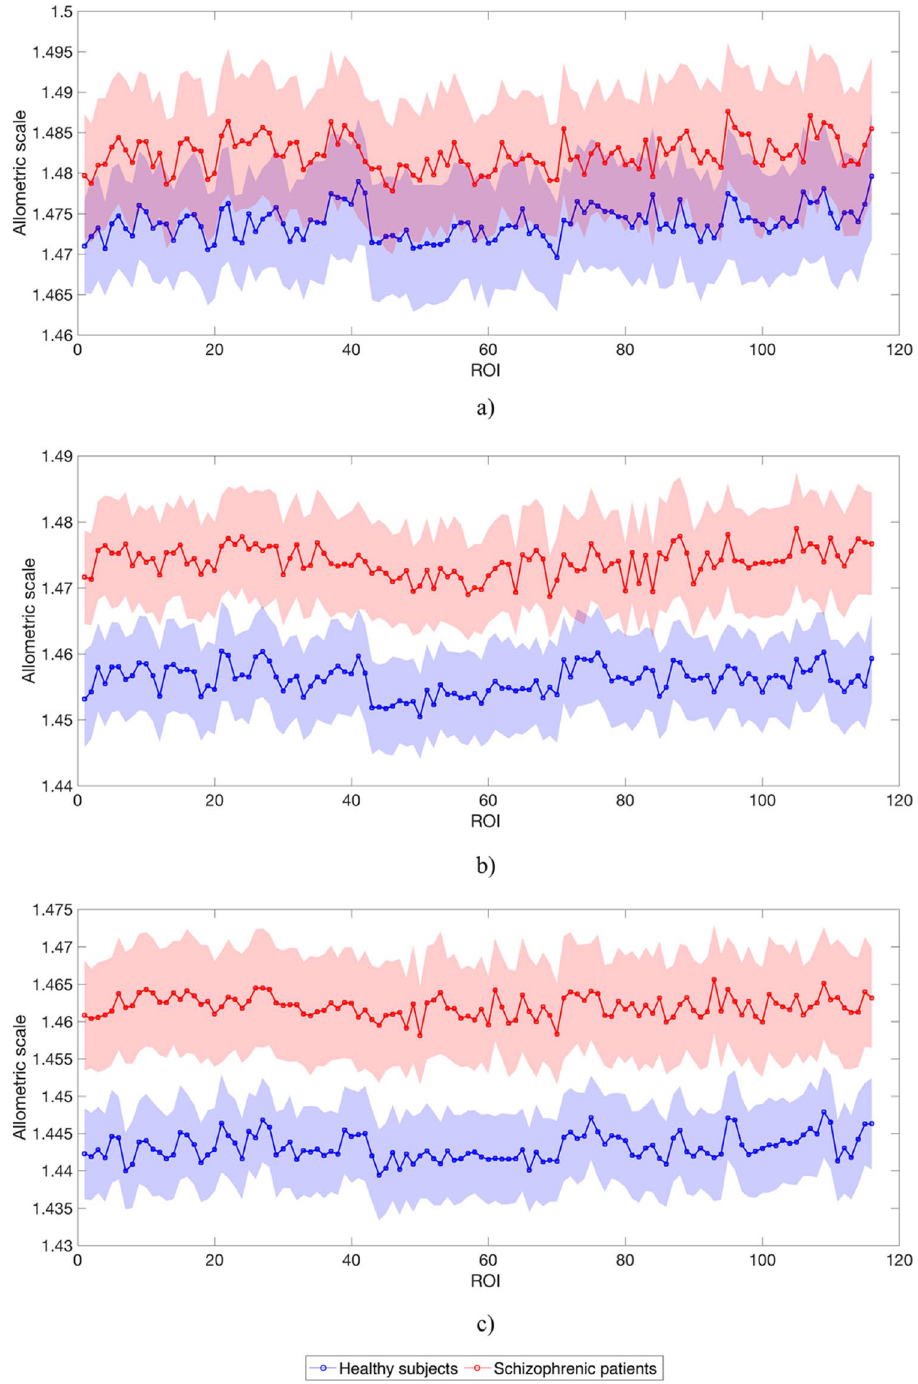
Figure 9. Allometric exponent for higher-order MSTs. Mean allometric exponent η, separately averaged over the two groups HC and SCZ, with 95% confidence interval for the second, third and fourth rank MSTs. The speed of reduction (SR) of the allometric exponent is larger for SCZ than for HC. An exponential fit (η(rank) = (η 0 − η ∞ ) * exp(− rank/SR) + η ∞ ) of the average η across the ROIs returned SR HC = (0.61 ± 0.08) SR SCZ = (0.80 ± 0.10). Each ROI was chosen as a directionality